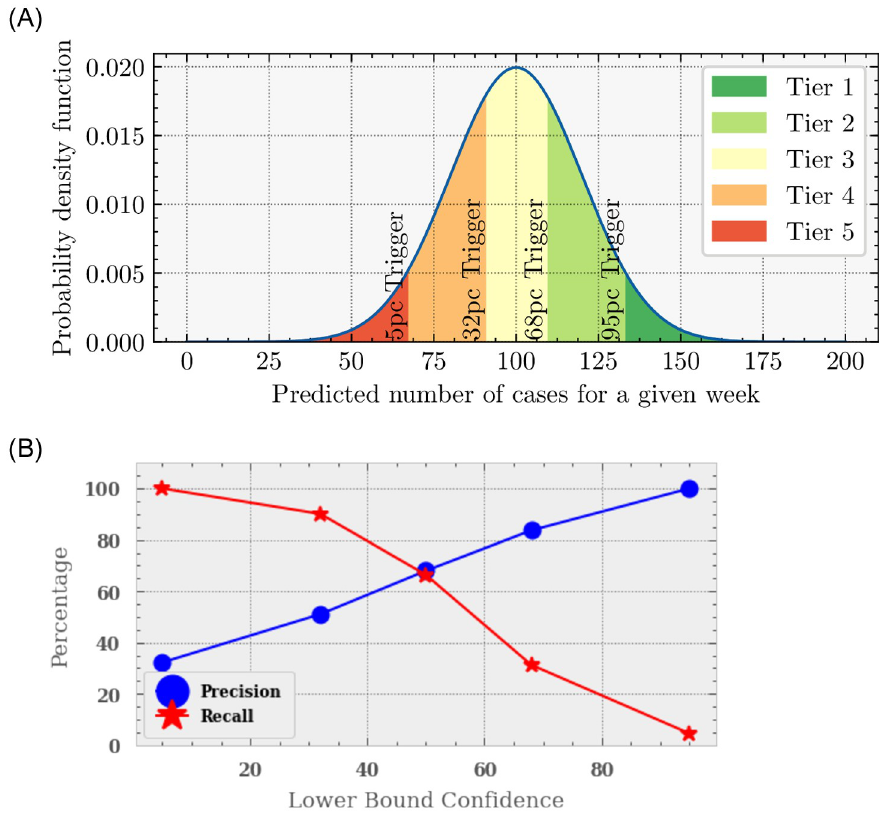
Fig 6. Top : How we trigger an alert for an epidemic. Here we show the predicted number of cases for a given week (of thirteen) and PHC. Each colour shows a different tier of alert and the associated percentile trigger. Should the WHO definition of an epidemic cross one of those triggers, an alert is made, with the associated precision and recall. Bottom : The precision and recall of the algorithm corresponding to these trigger levels. The precision (blue) is the fraction of true positives the algorithm makes from the total claimed positives and the recall (red) is the fraction of true positives from the total number of positives (or epidemics) there are. Here we show these as a function of the proportion of models predicting a case rate above the threshold. For those bounds that include more models that predict the case rate to go above the threshold we get a higher precision, however a lower recall.